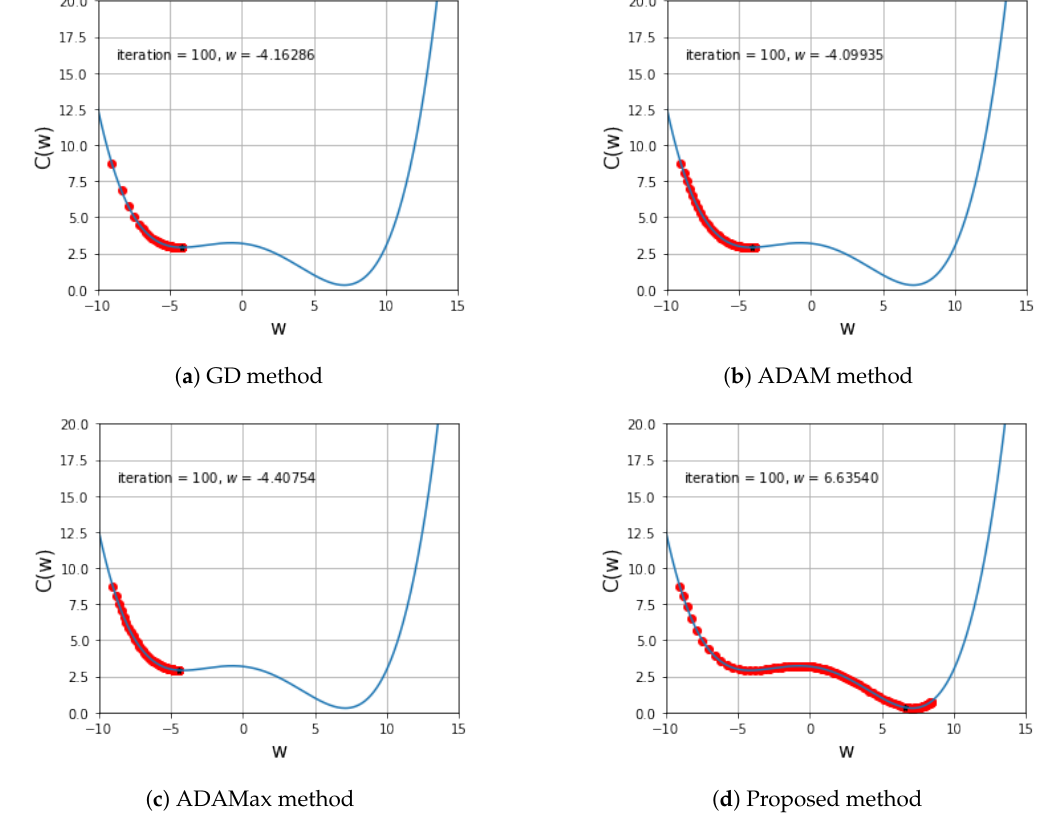
Figure 3. Compared to the other scheme, the learning rate is 0.2 and the β 1 , β 2 , λ used in the proposed method are 0.95, 0.9999, − 10 − 2 .